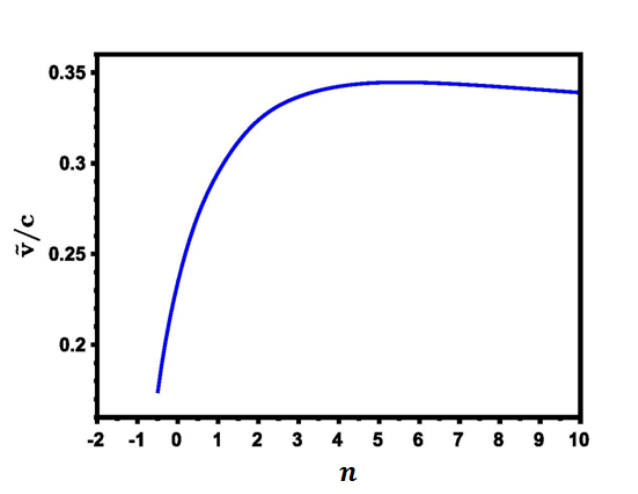
Figure 11: Variation of quantum speed of spin-up electron for transition from ground state to first excited state with different n at B